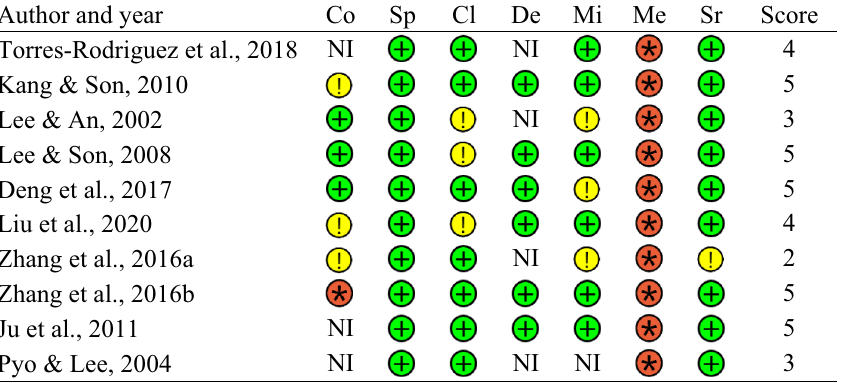
Figure 5. Overview of risk of bias results across all included studies. Cl bias in classification of interventions, Co bias due to confounding, De bias due to deviations from intended interventions, Me bias in measurement of the outcome, Mi bias due to missing outcome data, R bias arising from the randomization process, RoB risk of bias, ROBINS-I risk of bias in non-randomized studies of intervention, Sp bias in selection of participants in the study, Sr bias in selection of the reported